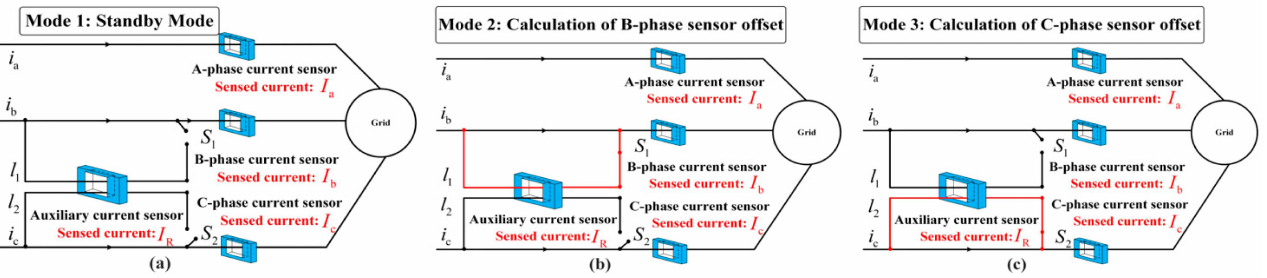
Figure 5. Operating modes of the auxiliary current sensor. ( a ) Mode 1: Normal condition. ( b ) Mode 2: Calculation of B-phase sensor zero-offsets. ( c ) Mode 3: Calculation of C-phase sensor zero-offsets.